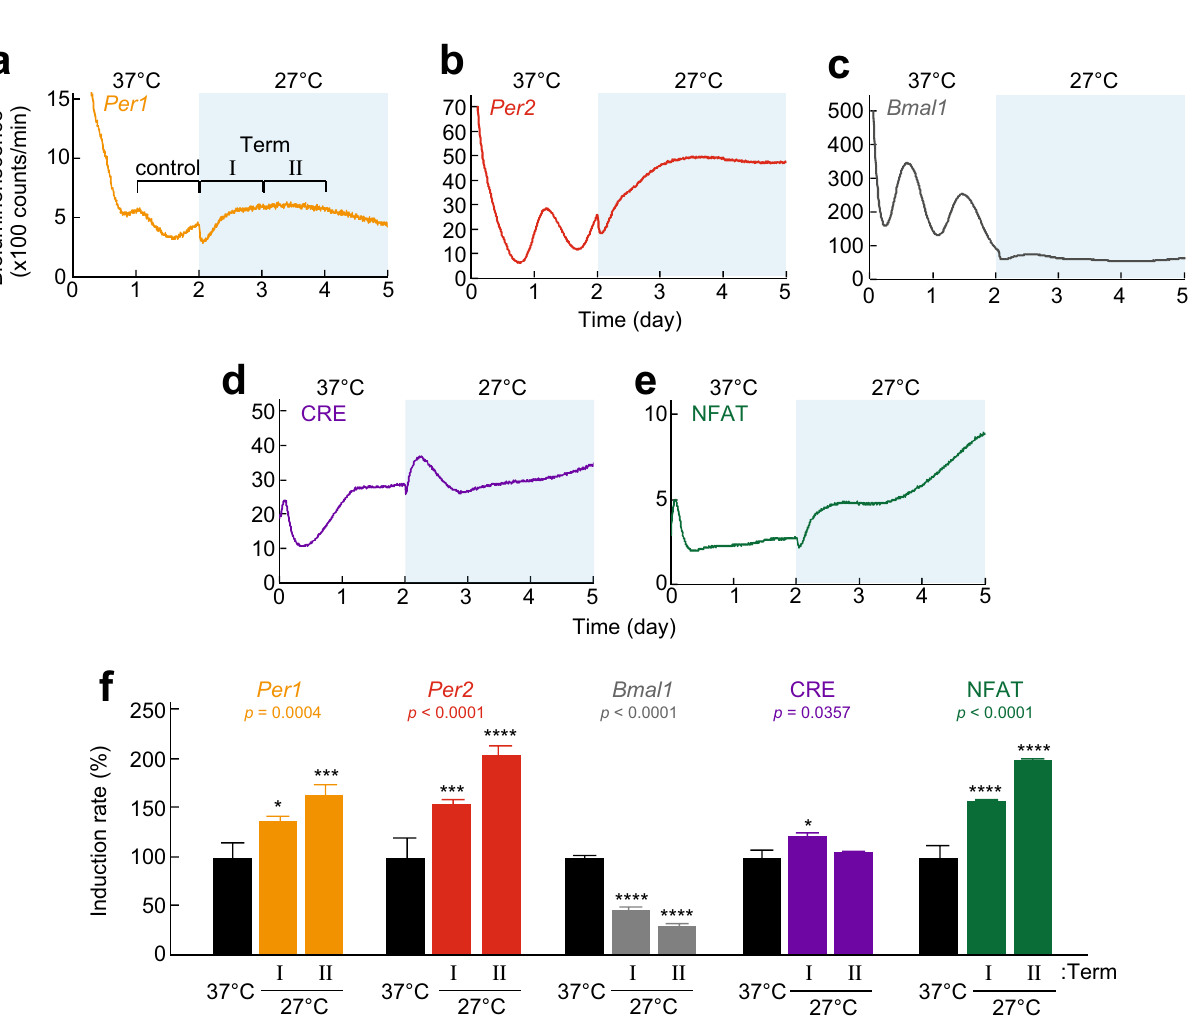
Figure 3. Effects of temperature shift on transcriptional reporters. Representative data of bioluminescence level of Per1 ( a ), Per2 ( b ), Bmal1 ( c ), CRE ( d ), or NFAT ( e ) luciferase reporters in temperature shift experiment. The reporter cells were cultured at 37 °C for 2 days and then temperature was decreased to 27 °C during the rest of the experiment. ( f ) Effect of temperature decrease from 37 to 27 °C on bioluminescence signals of reporter cell lines. The induction rate was calculated by dividing the AUC during Term I or Term II (27 °C) by the AUC during day 1 to 2 (control, 37 °C) (marked as example in panel a ). The means of induction rate at 37 °C was set to 100 in vertical axis. Mean with s.e.m. from 4, 8, 8, 4 or 3 independent samples for Per1 , Per2 , Bmal1 , CRE, or NFAT luciferase reporter cells are shown, respectively. p values: one-way ANOVA among induction rate in Term I, II and control. * p < 0.05, ** p < 0.01, *** p < 0.001, **** p < 0.0001 compared to the data at 37 °C (Dunnett’s